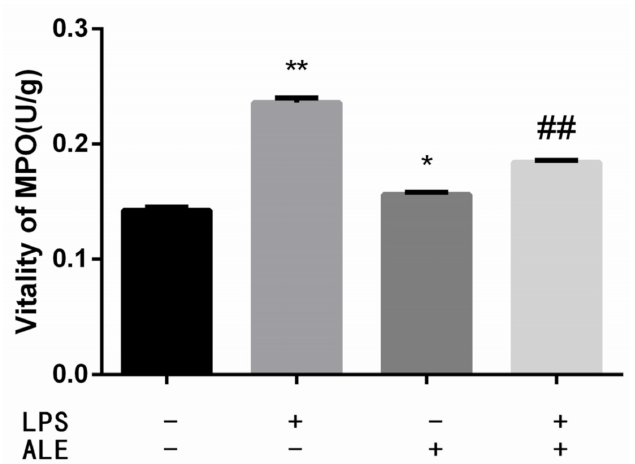
Figure 3. ALE reduced MPO activity in LPS-induced mouse mastitis. * p < 0.05, ** p < 0.01 vs. control group; ## p < 0.01 vs. LPS